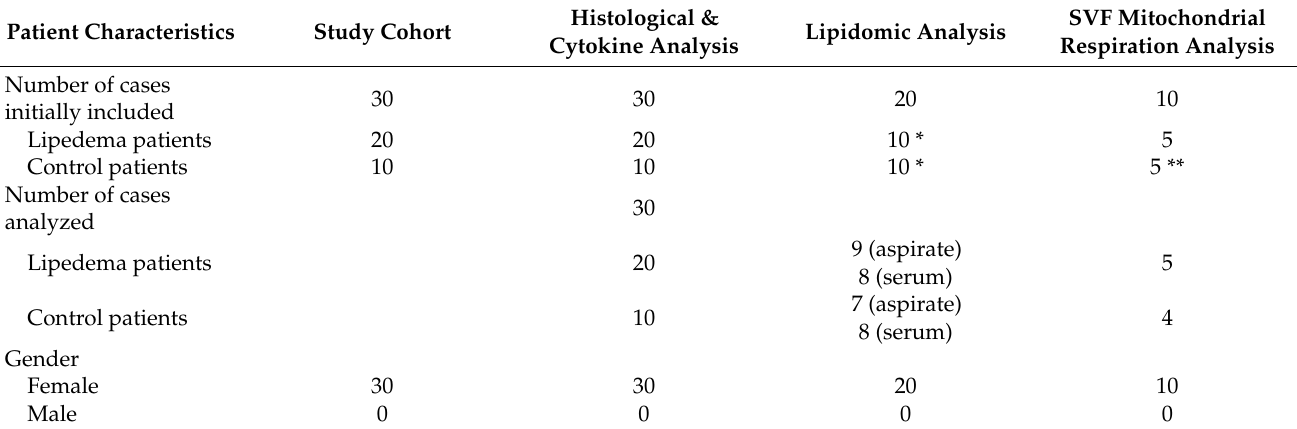
Table A1. Number of patients used in each type of